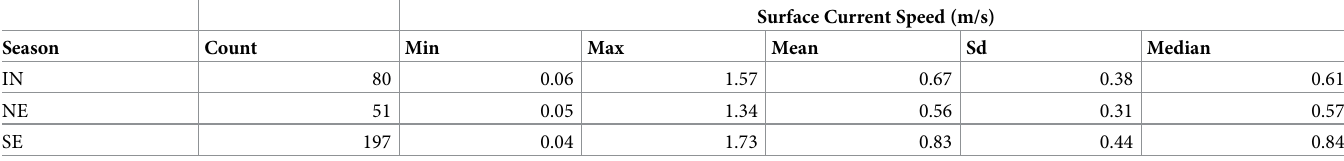
Table 5. Seasonal Statistical metrics of Surface current speeds in the Pemba Channel during the southeast (SE), northeast (NE) and inter-monsoon (IN) seasons.